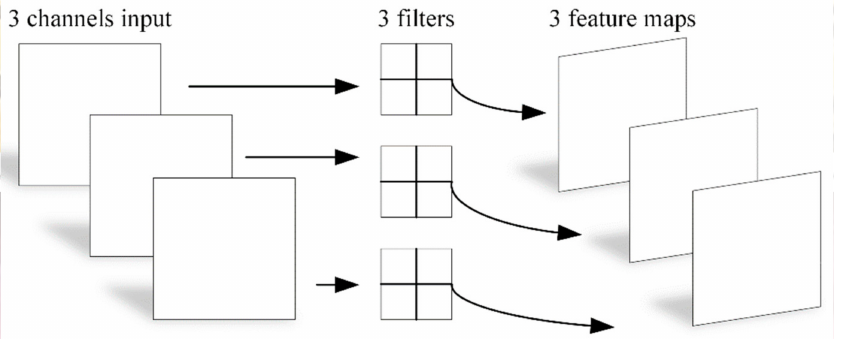
Figure 1. Overview of depthwise separable